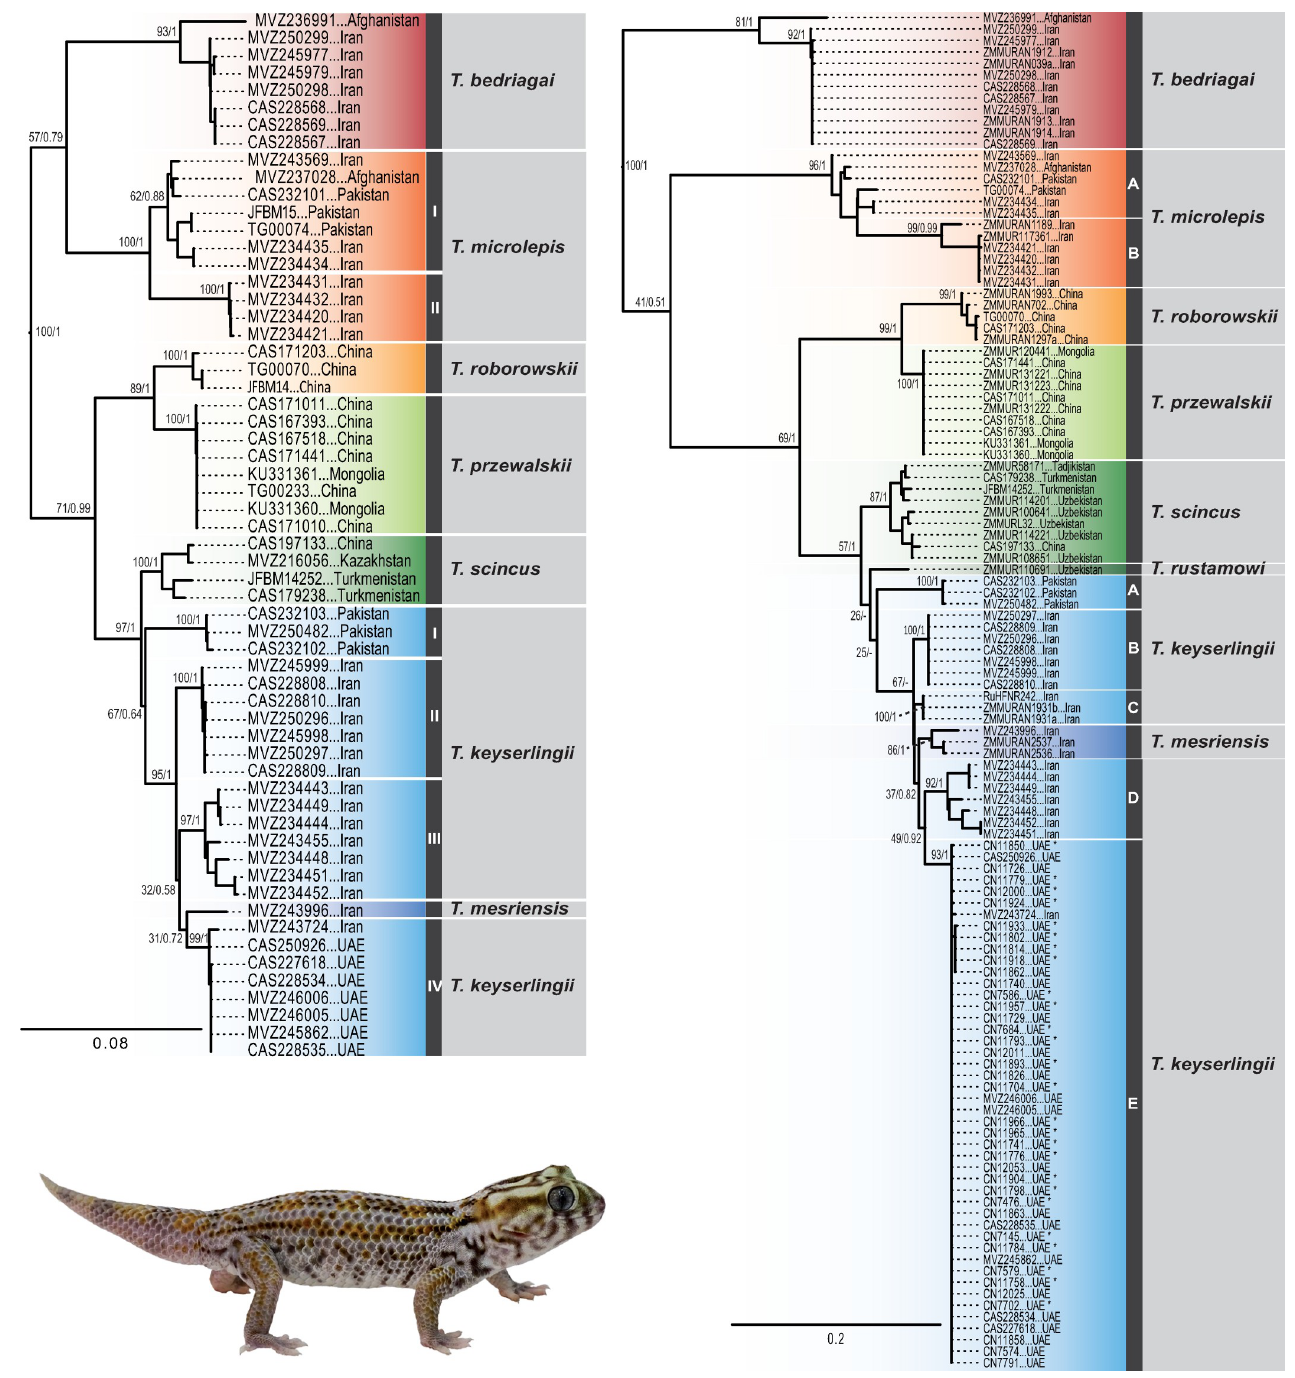
Fig 3. Maximum likelihood phylogenetic trees of Teratoscincus . (left) Phylogenetic tree using the concatenated mtDNA–nucDNA data ( COI , ND2 , MC1R , RAG1 ). (right) Phylogenetic tree using the COI data. Support values indicated near the nodes (ML bootstrap/Bayesian posterior probabilities). Sample codes correlate to specimens in S1 Table. Specimen depicted is T . keyserlingii from the UAE. Photo credit: Salvador Carranza.